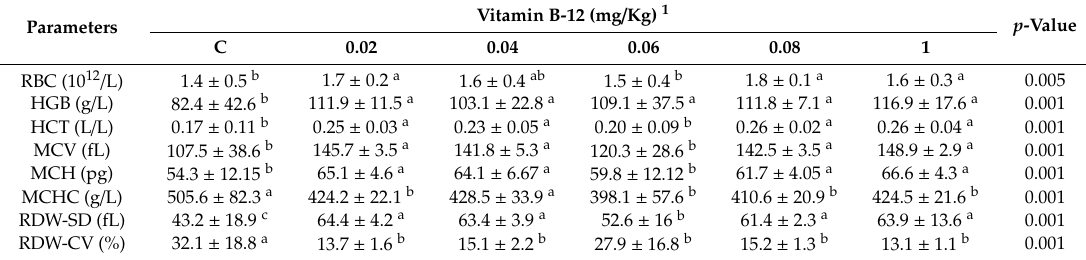
Table 4. E ff ect of dietary vitamin B12 on red blood cell count and its indices in meat-type Pekin ducks (mean ±